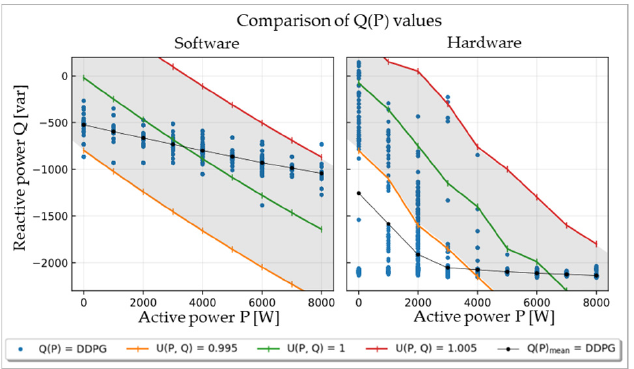
Figure 6. Sections of voltage curves corresponding to agent in software (SW) ( a ) and hardware (HW) ( b ) environments with associated active and reactive power values in SW ( c ) and HW ( d ) during the test run.